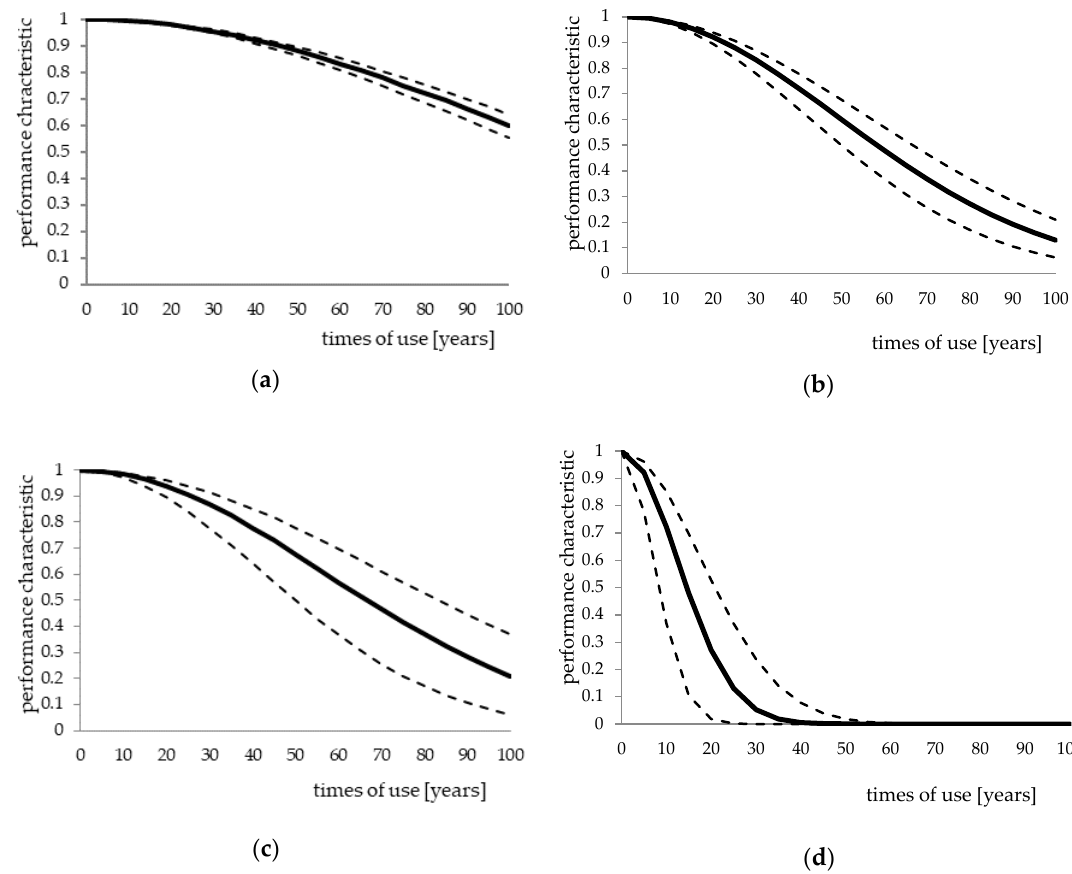
Figure 1. Changes in the performance values of building components: ( a ) Masonry walls, ( b ) wooden floors ( c ) wooden rafter, ( d ) gutters, and drain pipes.